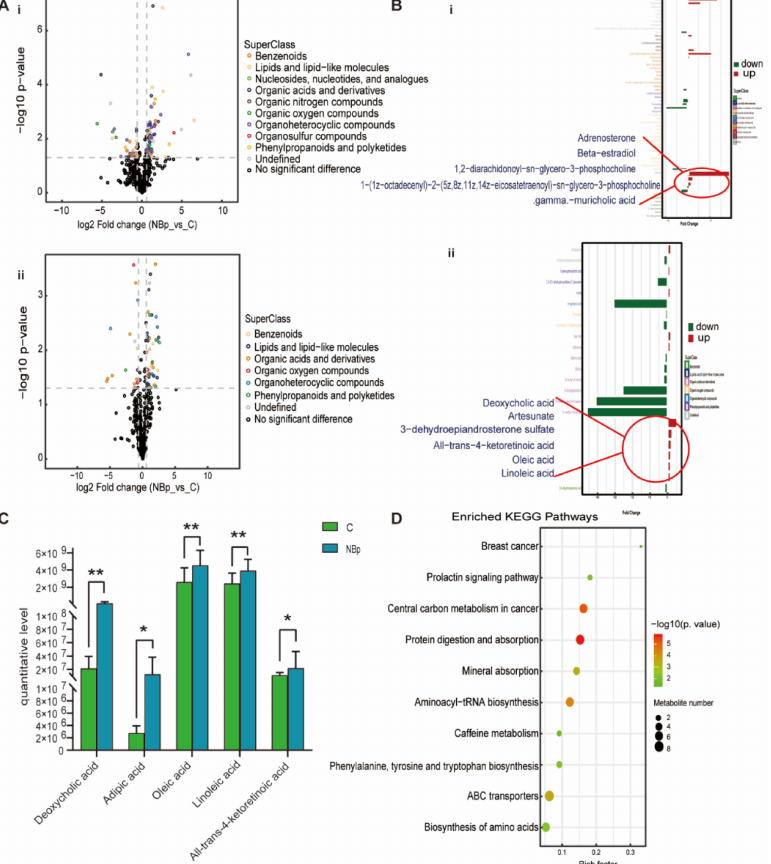
Figure 3. Analysis of differential metabolites between NBp vs. C. ( A ) Volcanic maps of positive (i) and negative (ii) ion modes. Points on the right half of volcano plot represent up-regulated metabolites satisfying FC > 1.5, p < 0.05, and points on the left half represent down-regulated metabolites satisfying FC < 0.67, p < 0.05, and black points on behalf of non-differential metabolites. ( B ) (i,ii) Bar graphs of the positive and negative ion modes. The abscissa indicates the fold change (FC). Red bars on behalf of up-regulated metabolites satisfying FC > 1, p < 0.05, green bars on behalf of down-regulated metabolites satisfying FC < 1, p < 0.05. The ordinate represents significantly distinctive metabolites. Local enlarged view for lipids and lipid-like molecules. ( C ) Differential metabolites unique to the NBp group. (* p < 0.05, ** p < 0.01). ( D ) KEGG pathway enrichment bubble diagram. The vertical axis represents the KEGG metabolic pathway, and the horizontal axis represents the rich factors (the ratio of the number of differential metabolites to the number of annotated metabolites in this pathway). The redder the circle color, the smaller the p -value of enrichment analysis and the higher the channel significance